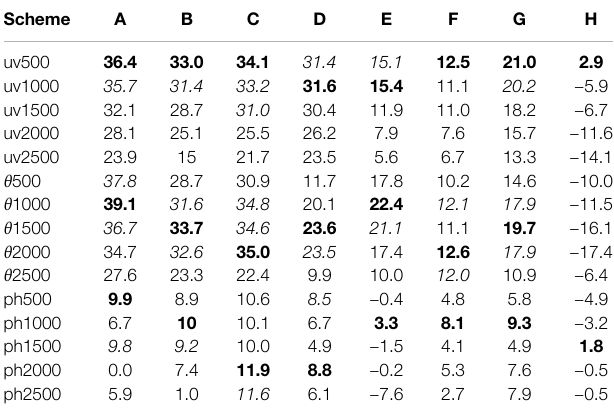
TABLE2| Meanimprovementrate(RATE)(%)ofsimulatedsurfacemeteorological fi elds under different cutoff wavelengths with nudging single variables in summer2009(boldtypeindicatestheoptimalRATEinagivensubregion,anditalic values indicate the schemes with RATE values greater than 90% of the optimal